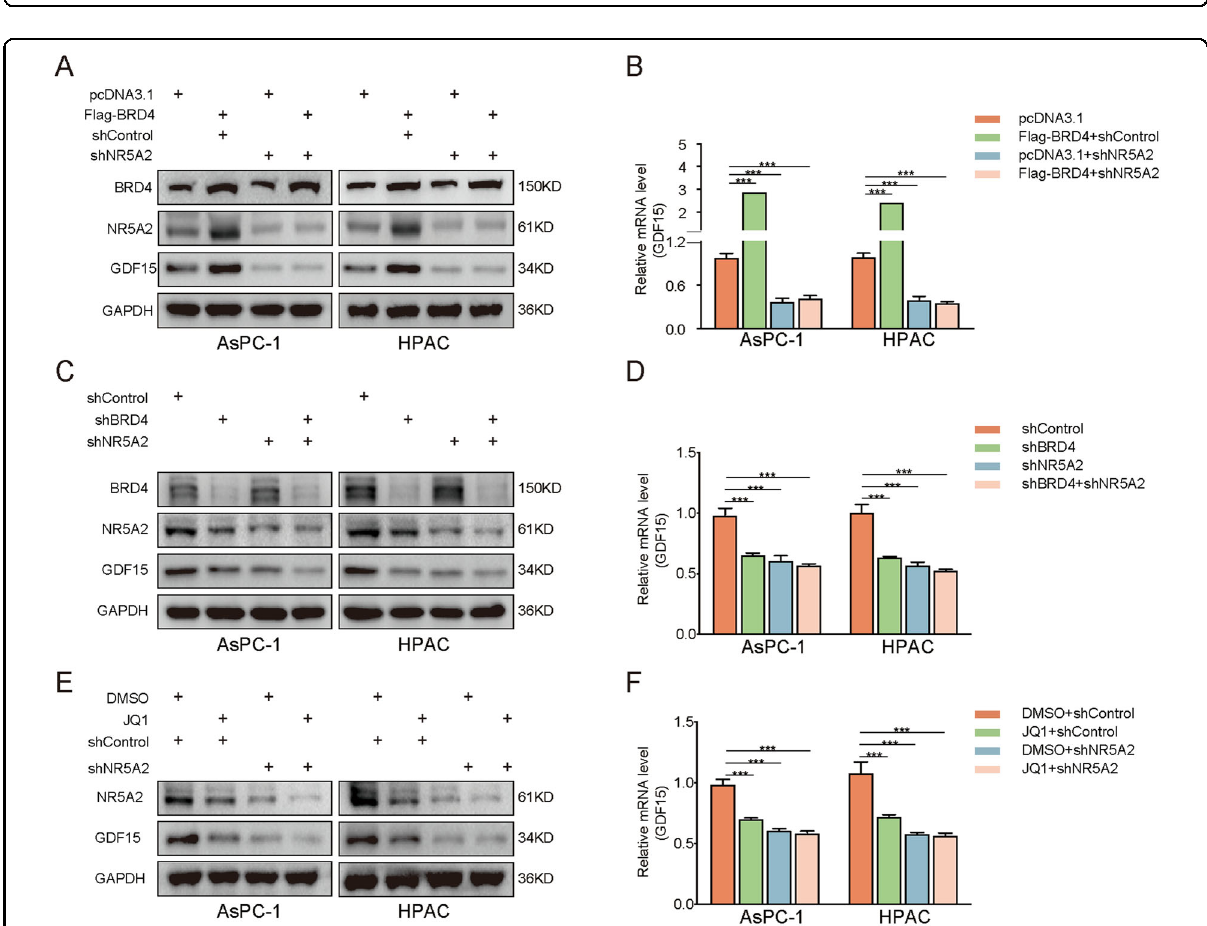
Fig. 7 BRD4 upregulated the expression of GDF15 by inducing NR5A2 expression. A , B . Western blot analysis ( A ) and RT-qPCR ( B ) to show the GDF15 expression in AsPC-1 and HPAC cells infected with pcDNA3.1, BRD4, shNR5A2, or BRD4 + shNR5A2. GAPDH served as an internal reference. Each bar represents the mean ± SD of three independent experiments. *** p < 0.001. Statistical analyses were performed using one-way ANOVA. C , D Western blot analysis ( C ) and RT-qPCR ( D ) to show the GDF15 expression in AsPC-1 and HPAC cells infected with shControl, shBRD4, shNR5A2, or shBRD4 + shNR5A2. GAPDH served as an internal reference. Each bar represents the mean ± SD of three independent experiments. *** p < 0.001, one- way ANOVA. E , F Western blot analysis ( E ) and RT-qPCR ( F ) to show the GDF15 expression in AsPC-1 and HPAC cells infected with shControl or shNR5A2 and treated with or without JQ1. GAPDH served as an internal reference. Each bar represents the mean ± SD of three independent experiments. *** p < 0.001, one-way